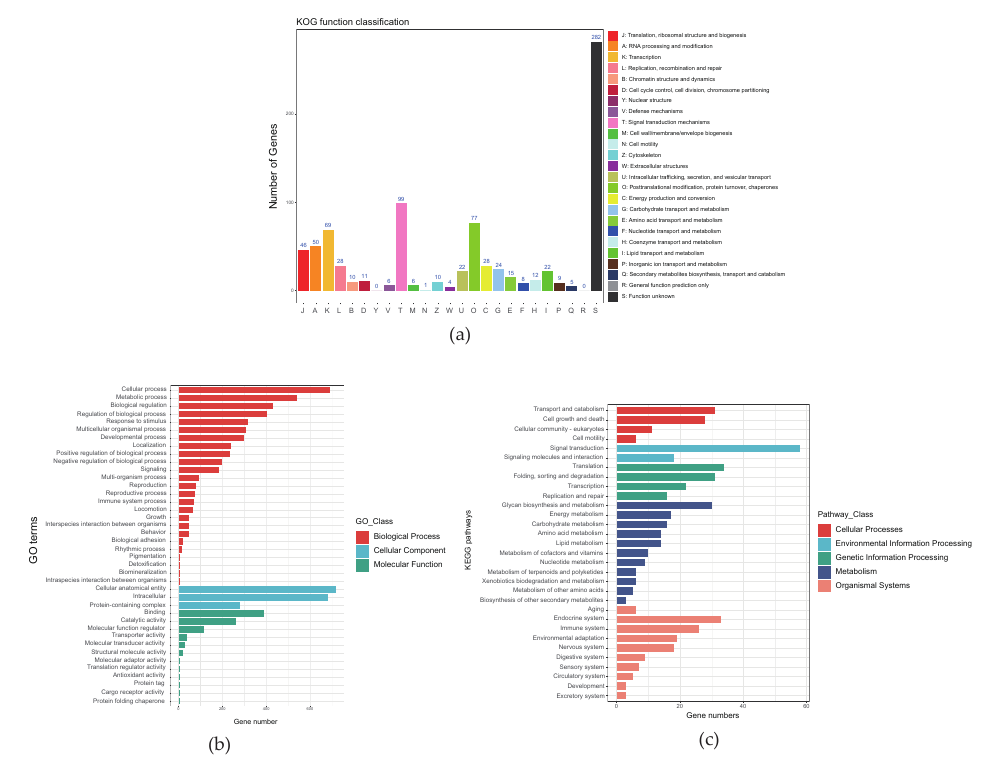
Figure 6. Annotation information of all single-copy homologous genes of the shimofuri goby based on three databases: ( a ) KOG classification of all single-copy homologous genes; ( b ) GO classification of all single-copy homologous genes; and ( c ) KEGG classification of all single-copy homologous genes.